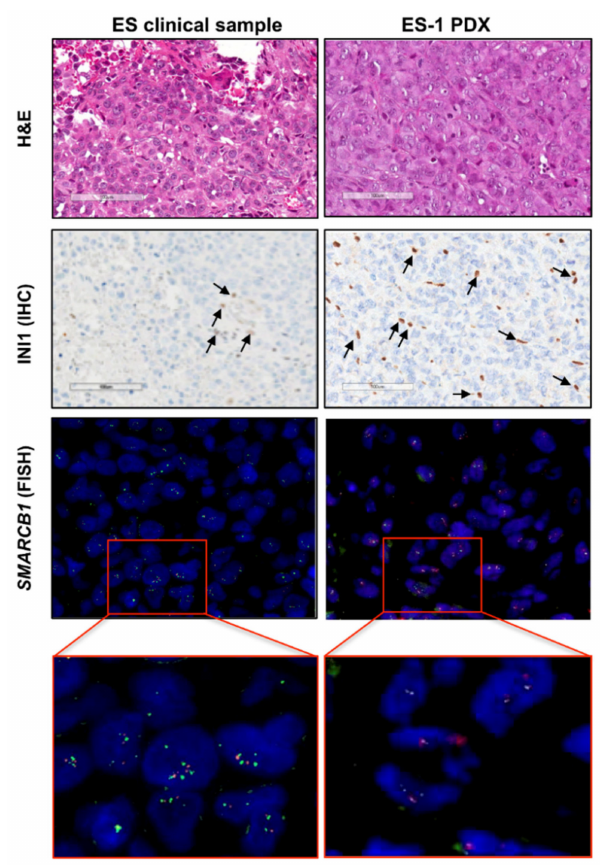
Figure1. Characterizationofthepatient-derivedxenograft(PDX)modelincomparisontotheoriginalclinical tumor. Representative pictures of the PDX model (epithelioid sarcoma (ES)-1 PDX) and